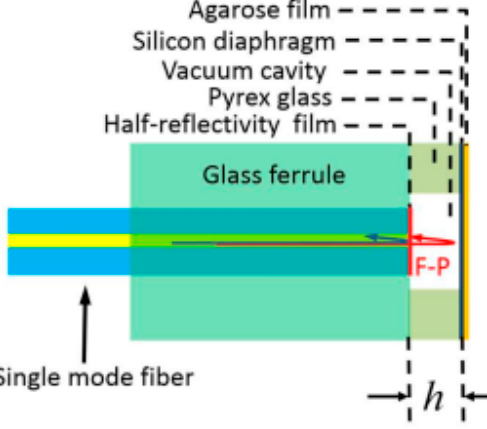
Figure 9. Schematic configuration of the humidity-sensitive FPI.